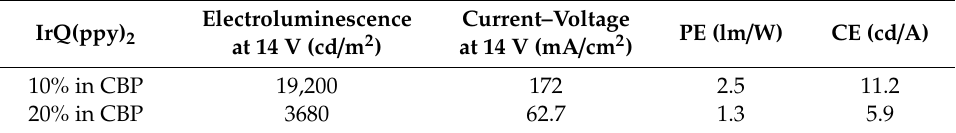
Table 1. Electroluminescent e ffi ciency